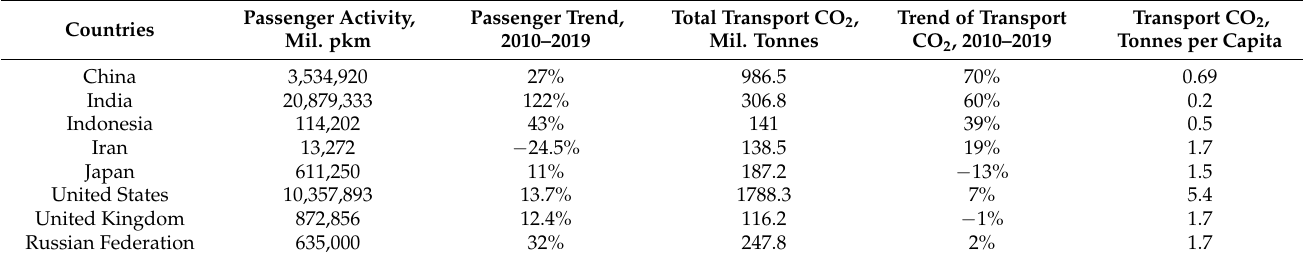
Transport CO 2 , Tonnes per Capita